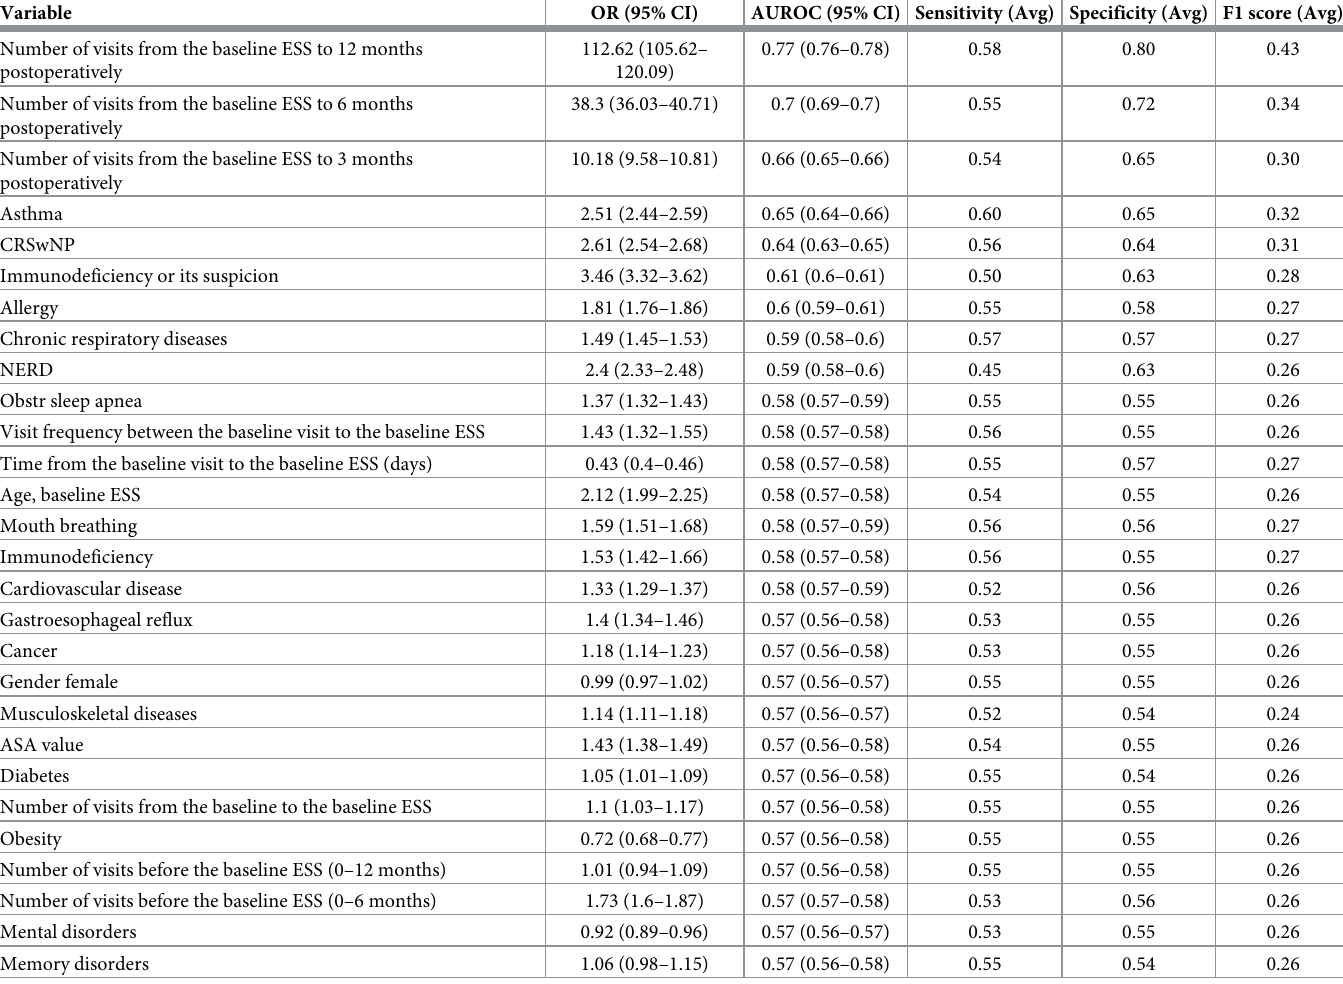
Table 3. Odds ratios (ORs) and performance values (AUROC, sensitivity, specificity and F1 score) for predicting a revision ESS using different variables in univari- ate logistic regression models.